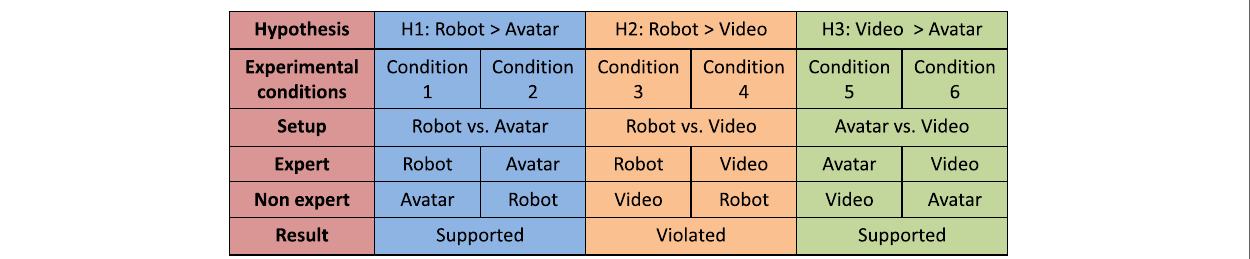
FigUre 1 | Overview on the experimental hypotheses, protocol, and results